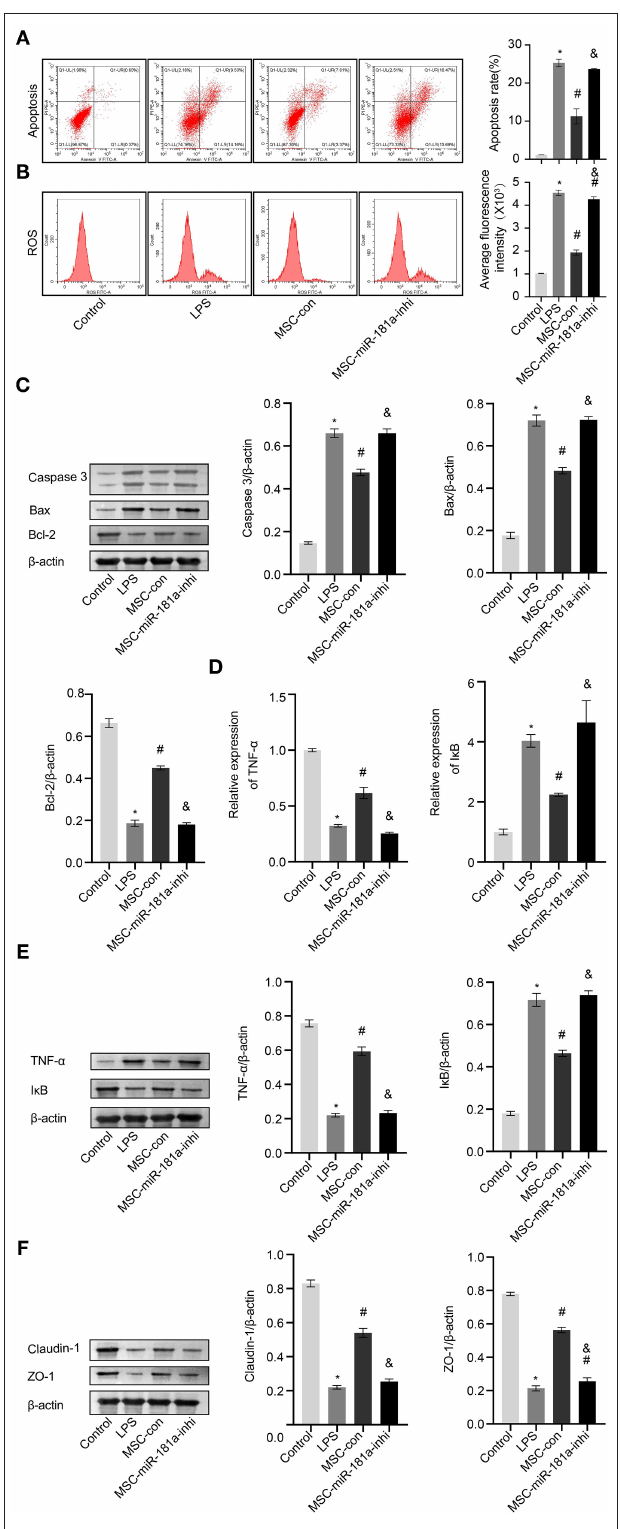
FIGURE 6 | Exosomal miR-181a rescued LPS-induced damage in vitro . (A) HCOEPIC apoptosis was detected by flow cytometry. (B) Measurement of ROS in the HCOEPICs. (C) Western blotting was used to detect the